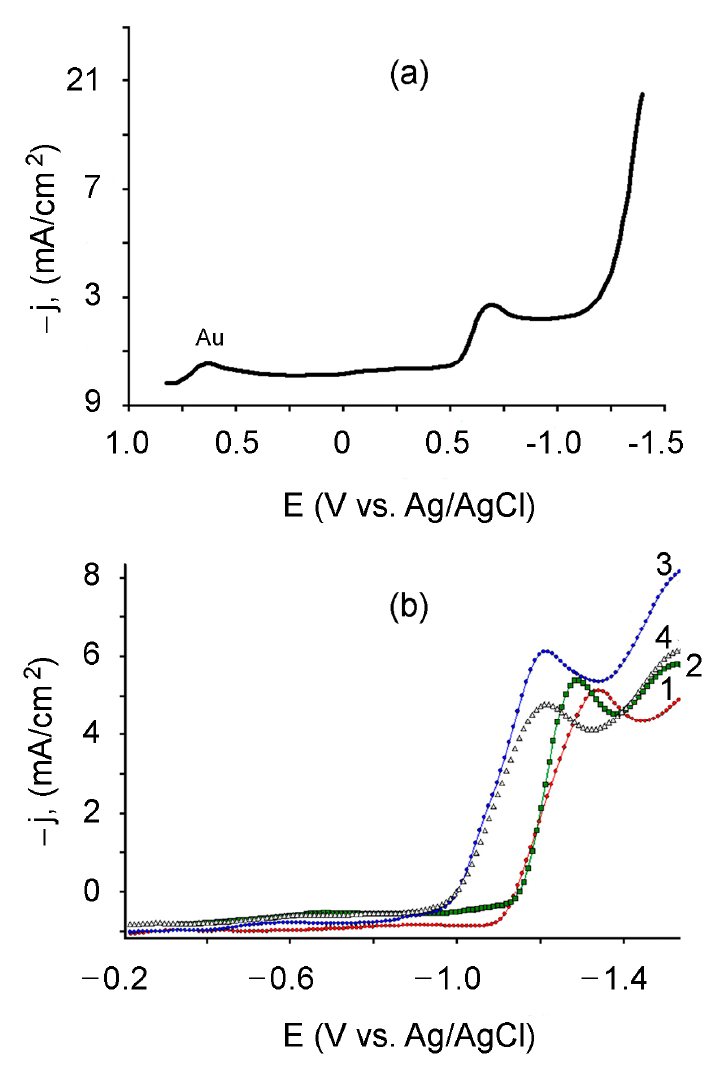
Figure 4. Polarization curves recorded in: ( a )—5 mmol/L HAuCl 4 /0.1 mol/L LiClO 4 , ( b )—electrolyte 1 (1), electrolyte 2 (2), electrolyte 3 (3), electrolyte 4 (4). The potential sweep rate is 10 mV/s.